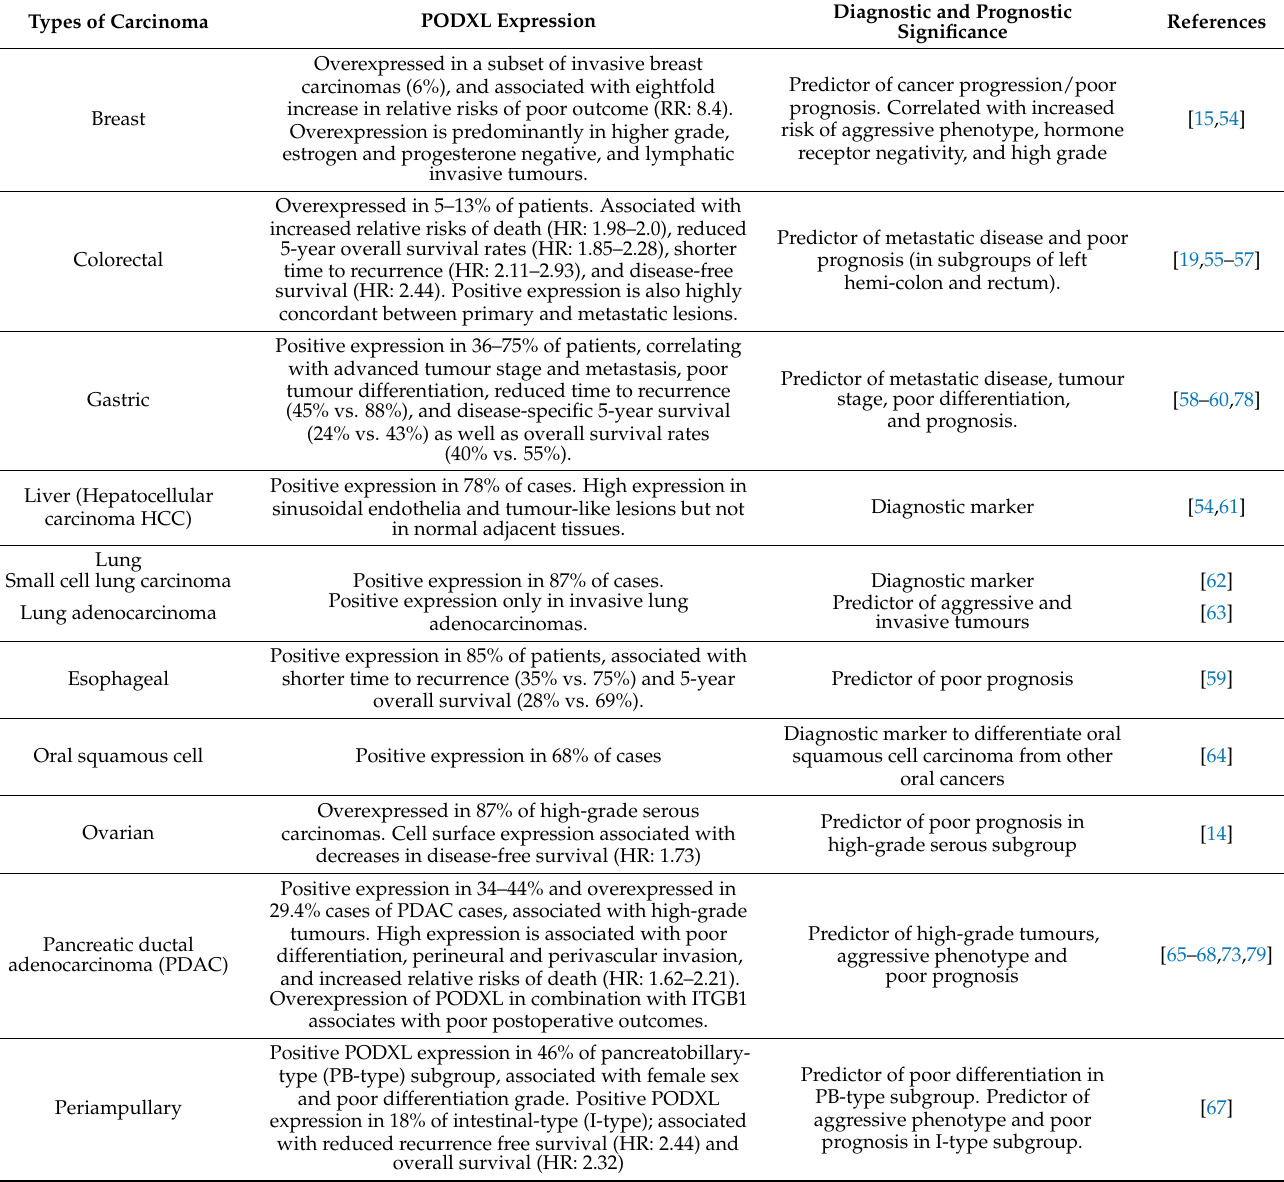
Table 1. Summary of PODXL expression profiles in epithelial